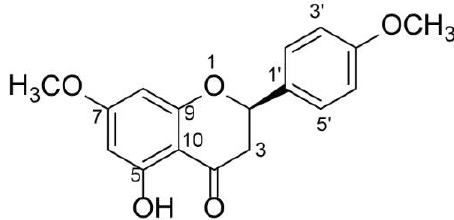
(cid:48) ,7-dimethyl ether (( −